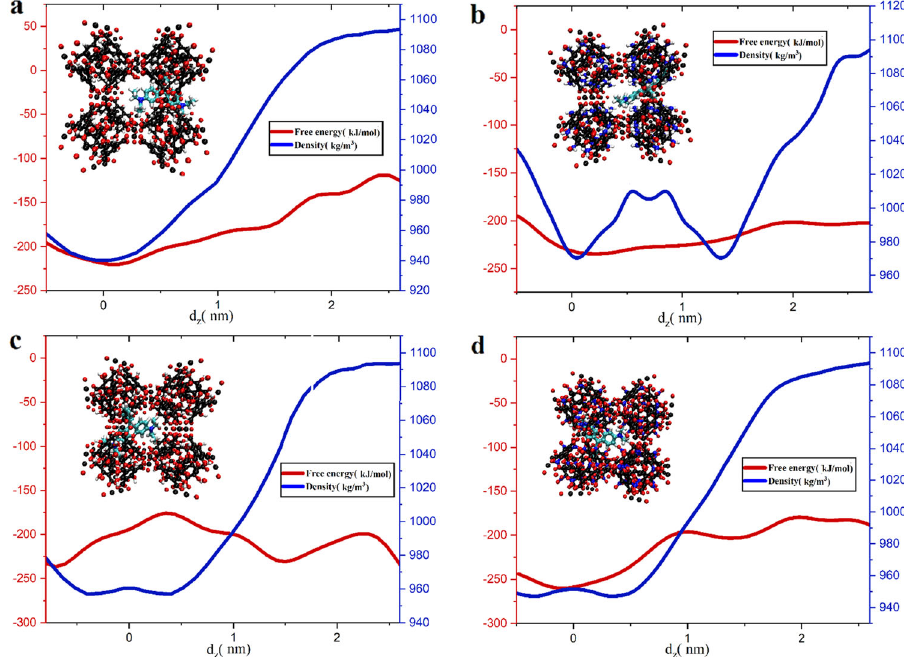
Fig. 7 The water density pro fi le and FE landscape. For the adsorption of Rh B on a the Cu-BTC/MOF (MOF-Rh B system) and F-MOF surfaces b MOF-NH 2 system, c MOF-OH system and d MOF-NO 2 system as a function of their center of